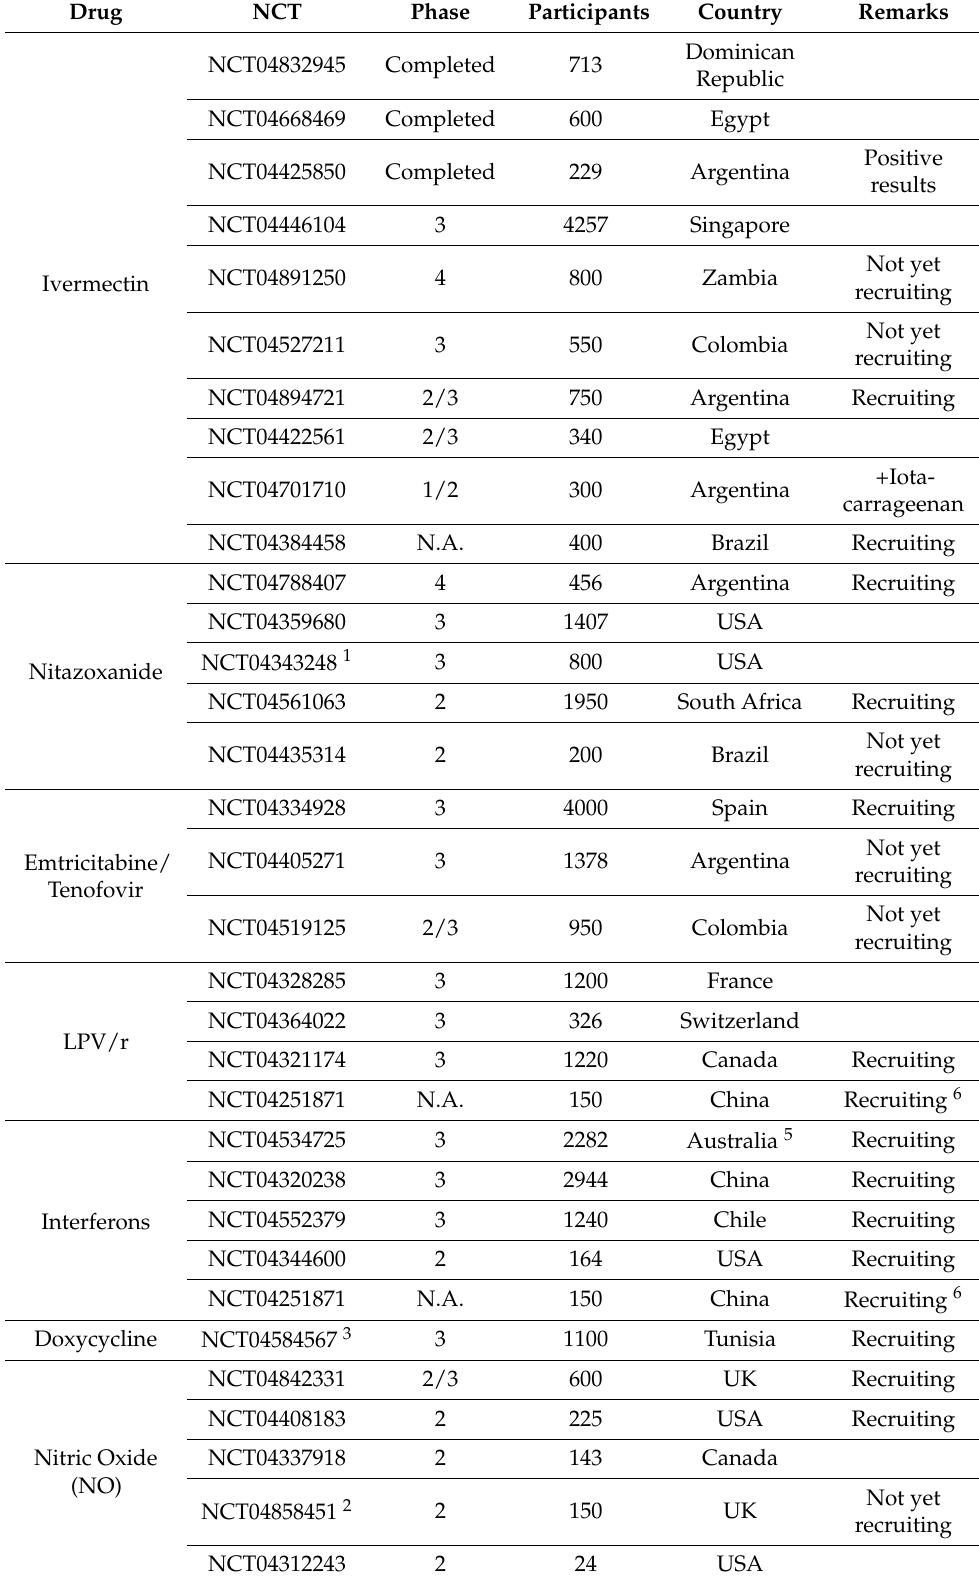
Table 3. Clinical trials status of candidate for SARS-CoV-2 prophylactic drugs